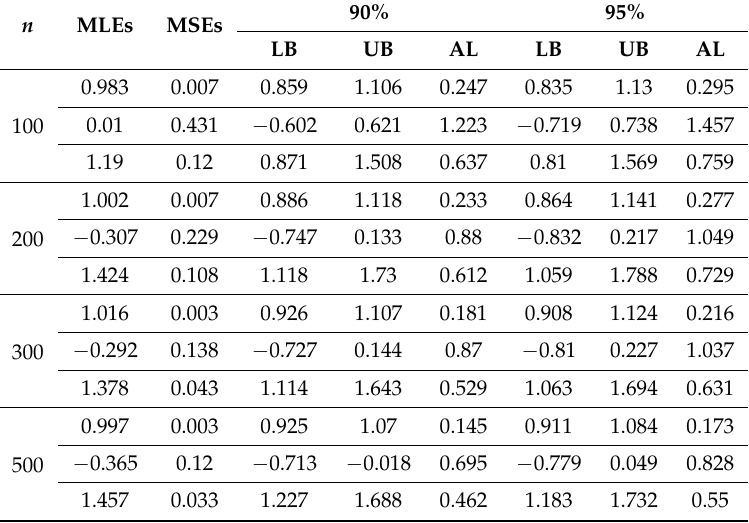
Table 6. Numerical measures of interest of the TOFrE model for Set4 (1, − 0.5,